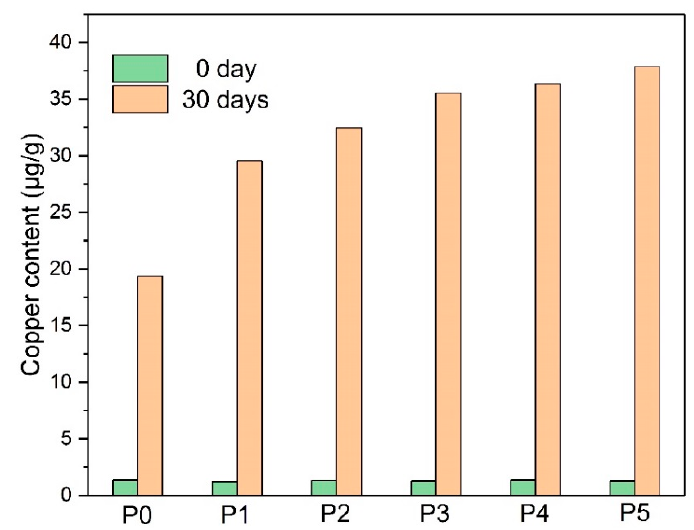
Figure 6. The variation of the copper content in the paper with the aging process.